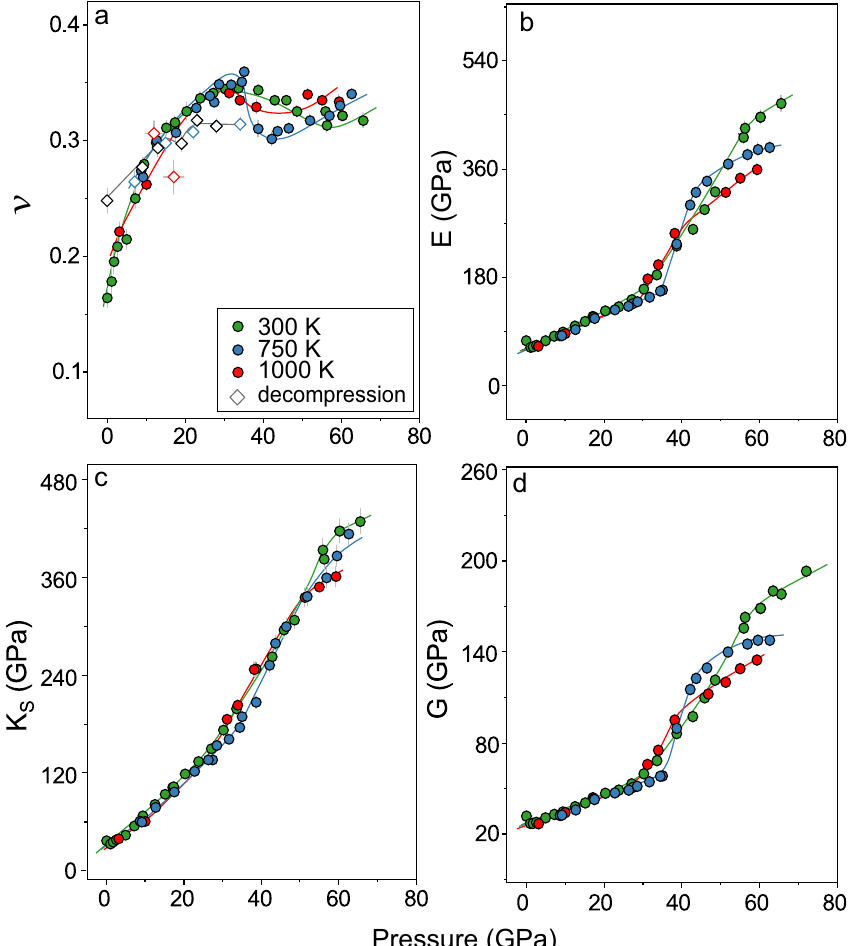
Figure 3. Poisson’s ratio, bulk, shear, and Young’s moduli of SiO 2 glass at high P–T conditions. ( a ) Poisson’s ratio ( ν ); ( b ) Young’s modulus ( E ); ( c ) bulk modulus ( K S ); ( d ) shear modulus ( G ). Green, blue, and red circles represent the velocity data at 300 K, 750 K and 1000 K by compression, respectively. Green, blue, and red diamonds are our results in decompression for SiO 2 -glass quenched from 300 K, 750 K, and 1000 K, respectively. All the colour solid lines are shown to guides the eyes for the pressure-dependent